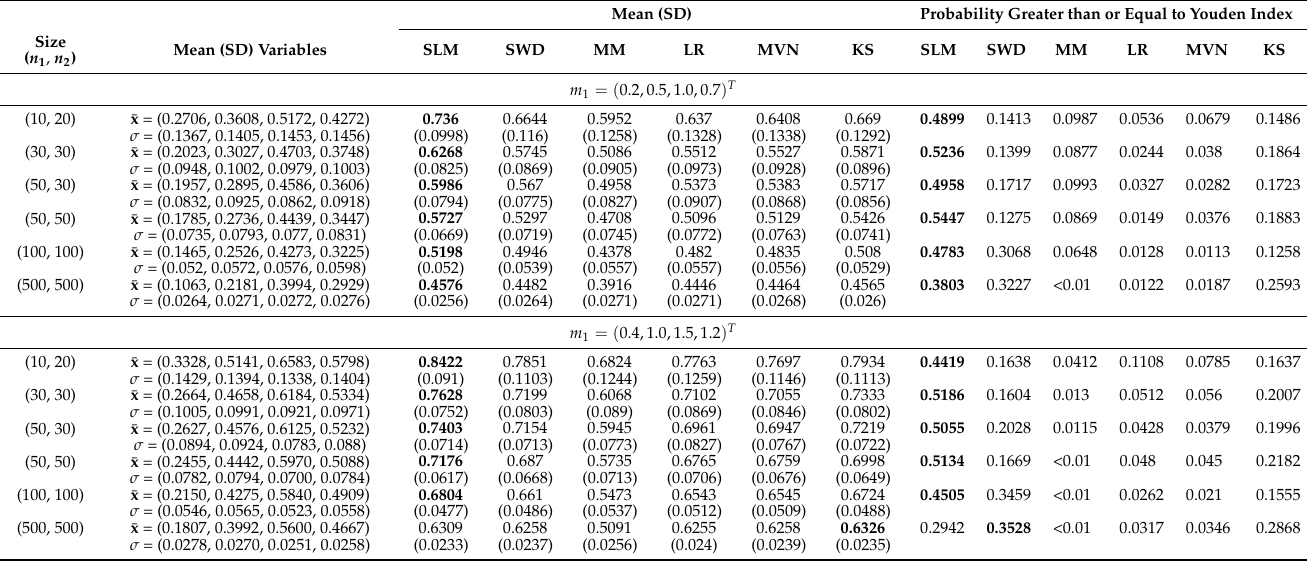
Table 5. Normal distributions: Different means. Different correlation ( Σ 1 = 0.3 · I + 0.7 · J , Σ 2 = 0.7 · I + 0.3 · J ).